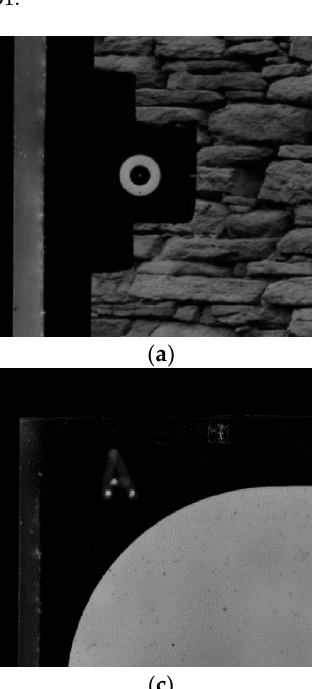
Figure 3. Images of one stereo-pair of the south wall of Padise Abbey: ( a ) Left image A1; ( b ) Right image B1.